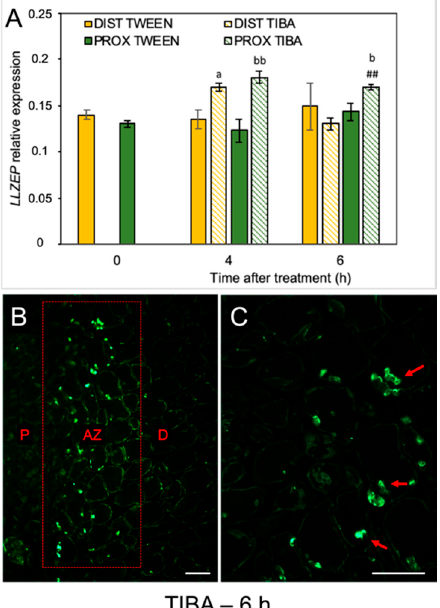
Figure 4. The disruption of polar auxin transport induced the LlZEP gene and altered the ABA localization in the abscission zone area. The relative level of LlZEP ( zeaxanthin epoxidase ) transcripts was investigated using qPCR ( A ). A solution of 2,3,5-triiodobenzoic acid (TIBA, 0.05 mM in 0.05% Tween 20) or 0.05% Tween 20 was applied directly on the inactive flower abscission zone (AZ). Subsequently, the tissue fragments containing the AZ ( ≈ 1 mm below and ≈ 1 mm above) were dissected 4 h or 6 h after treatments and divided into a proximal (PROX) and a distal (DIST) part for further RNA isolation. LlACT ( actin ) was used as an internal control for the normalization of gene expression. Values represent mean ± SD (n = 3). Error bars indicate SEs. t -test: a p < 0.05, TIBA-treated distal part versus Tween 20-treated distal part for different times after application; bb p < 0.01 and b p < 0.05, TIBA-treated proximal part versus Tween 20-treated proximal part for different times after application, ## p < 0.01, proximal versus distal part in the TIBA-treated AZ for different times after application. Immunofluorescence localization of ABA in the AZ area ( B ). Magnified region of the AZ ( C ). P—proximal side, D—distal side. Observations were carried out 6 h after the TIBA application. The presence of green fluorescence indicates ABA localization (marked by red arrowheads). Scale bars: 40 µM.